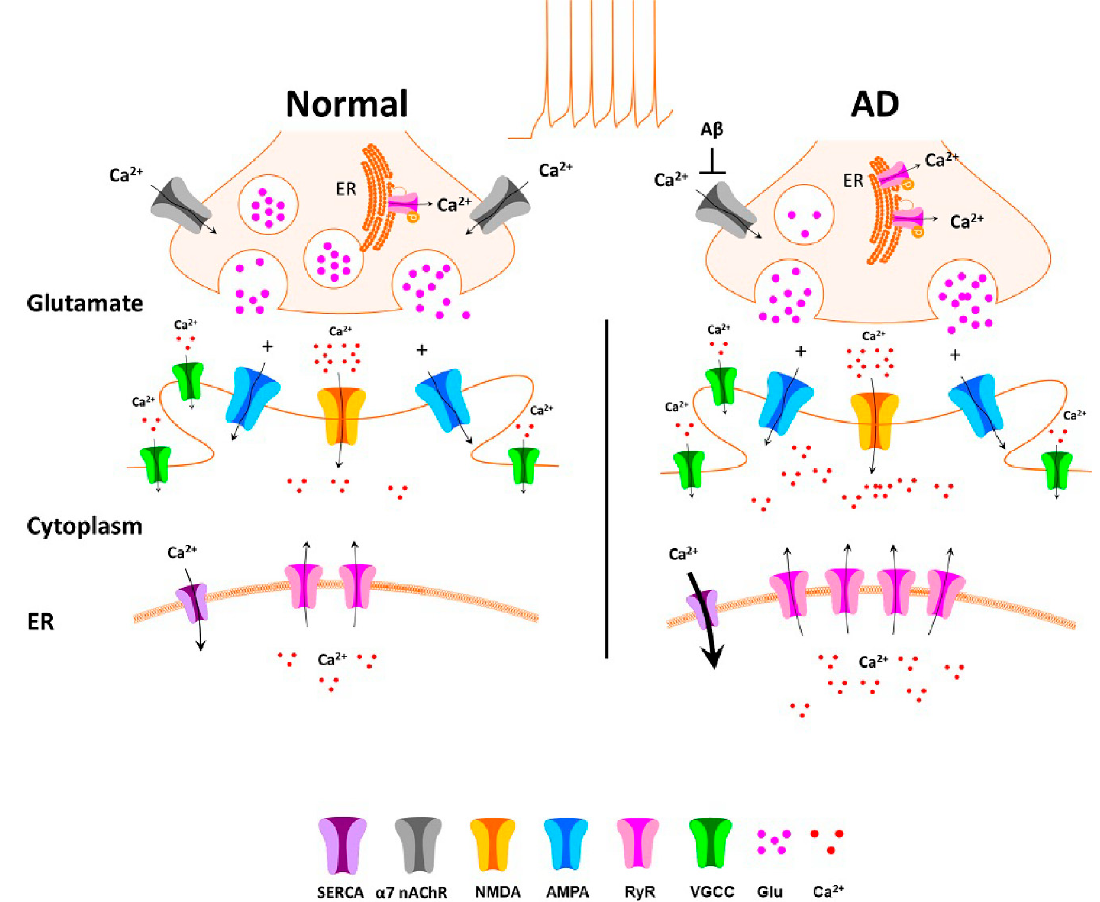
Figure 2. Schematic of synaptic Ca 2+ dysregulation in AD . Under normal circumstances (left), impulse mediated increases in presynaptic Ca 2+ result in neurotransmitter release via a ready releasable vesicular pool. In addition, activation of presynaptic α 7nAChRs triggers further Ca 2+ influx, thus facilitating impulse mediated release, and presynaptic effects may be further increased via presynaptic RyR mediated Ca 2+- induced-Ca 2+ release (CICR). In mouse models of AD, although intrinsic cell excitability is not increased, presynaptic RyR mediated CICR may be increased, resulting in increased release probability of glutamate and depletion of vesicle stores. A β binding to presynaptic α 7nAChRs may result in occlusion of the binding site, with decreased function and eventual decreased presynaptic α 7nAChR expression due to endocytosis. In AD, increased ER Ca 2+ stores, along with increased RyR expression results in increased postsynaptic CICR, which may facilitate stimulus-evoked postsynaptic Ca 2+ increases.